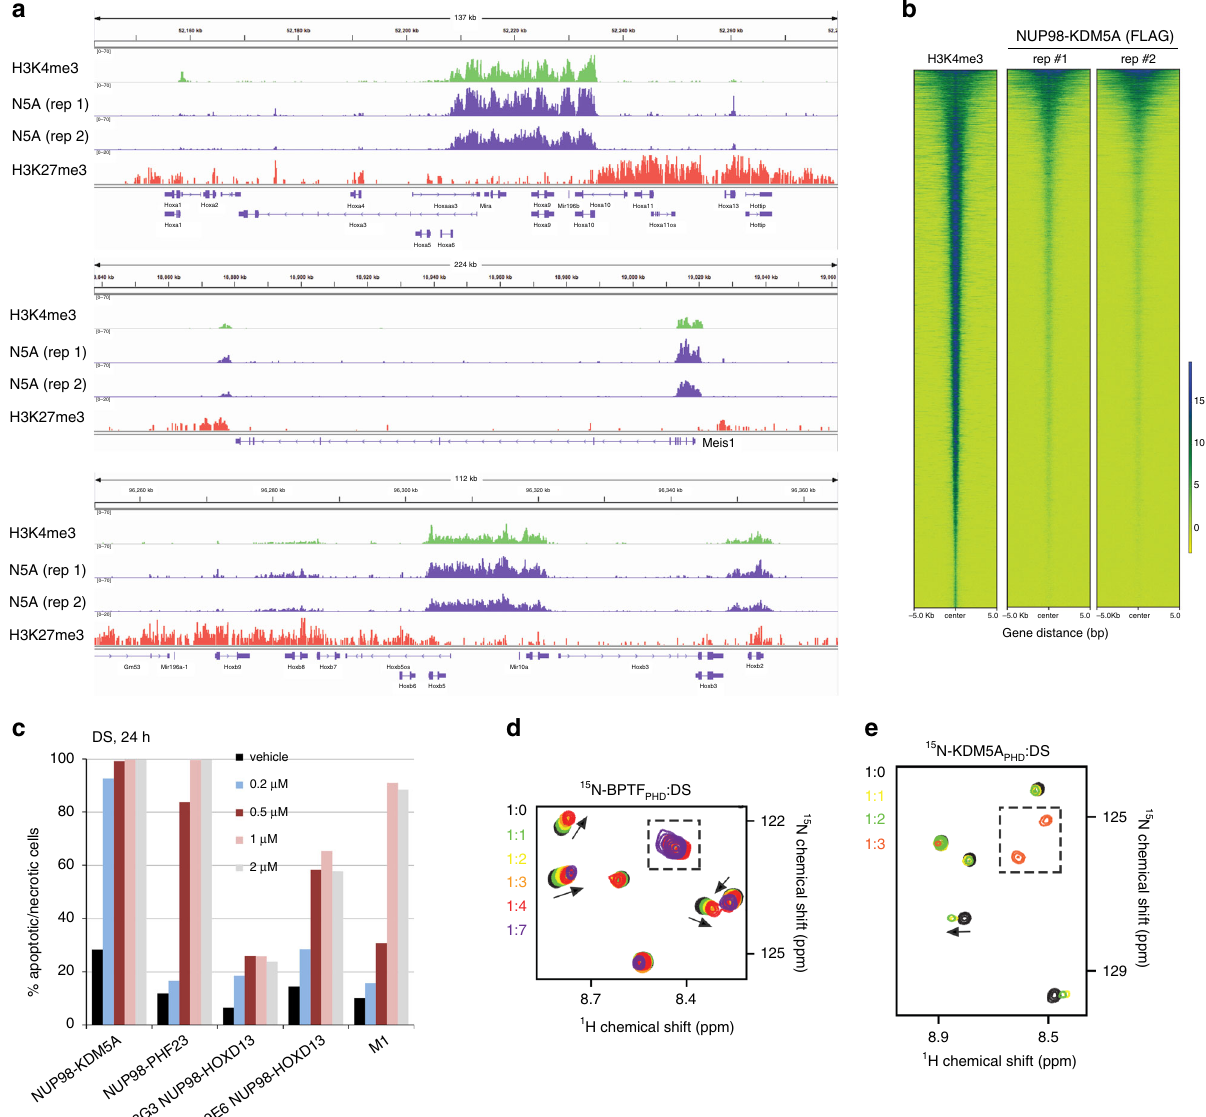
Fig. 6 NUP98 – KDM5A is enriched at H3K4me3 regions and is sensitive to DS. a ChIP-seq pro fi les of H3K4me3, NUP98 – KDM5A (N5A, two replicates), and H3K27me3 at the Hoxa, Meis1, and Hoxb loci in murine leukemia cells transformed by NUP98 – KDM5A. b Heatmap of H3K4me3 and two replicas of NUP98 – KDM5A ChIP-seq signals centered on H3K4me3-binding sites in a ±5.0-kb window in murine leukemia cells expressing FLAG-tagged NUP98 – KDM5A. ChIP-seq signals were normalized to input. c DS induces cell death of NUP98 – KDM5A expressing and NUP98 – PHF23 expressing AML cell lines at earlier time points and lower DS concentrations than the NUP98 – HOXD13 expressing cell line, con fi rming our previous results 9 . n = 1, source data are provided in the Source Data fi le. Superimposed 1 H, 15 N HSQC spectra of BPTF PHD d and KDM5A PHD e collected upon titration with DS. Spectra are color coded according to the protein:compound molar ratio. Dashed box indicates newly appeared